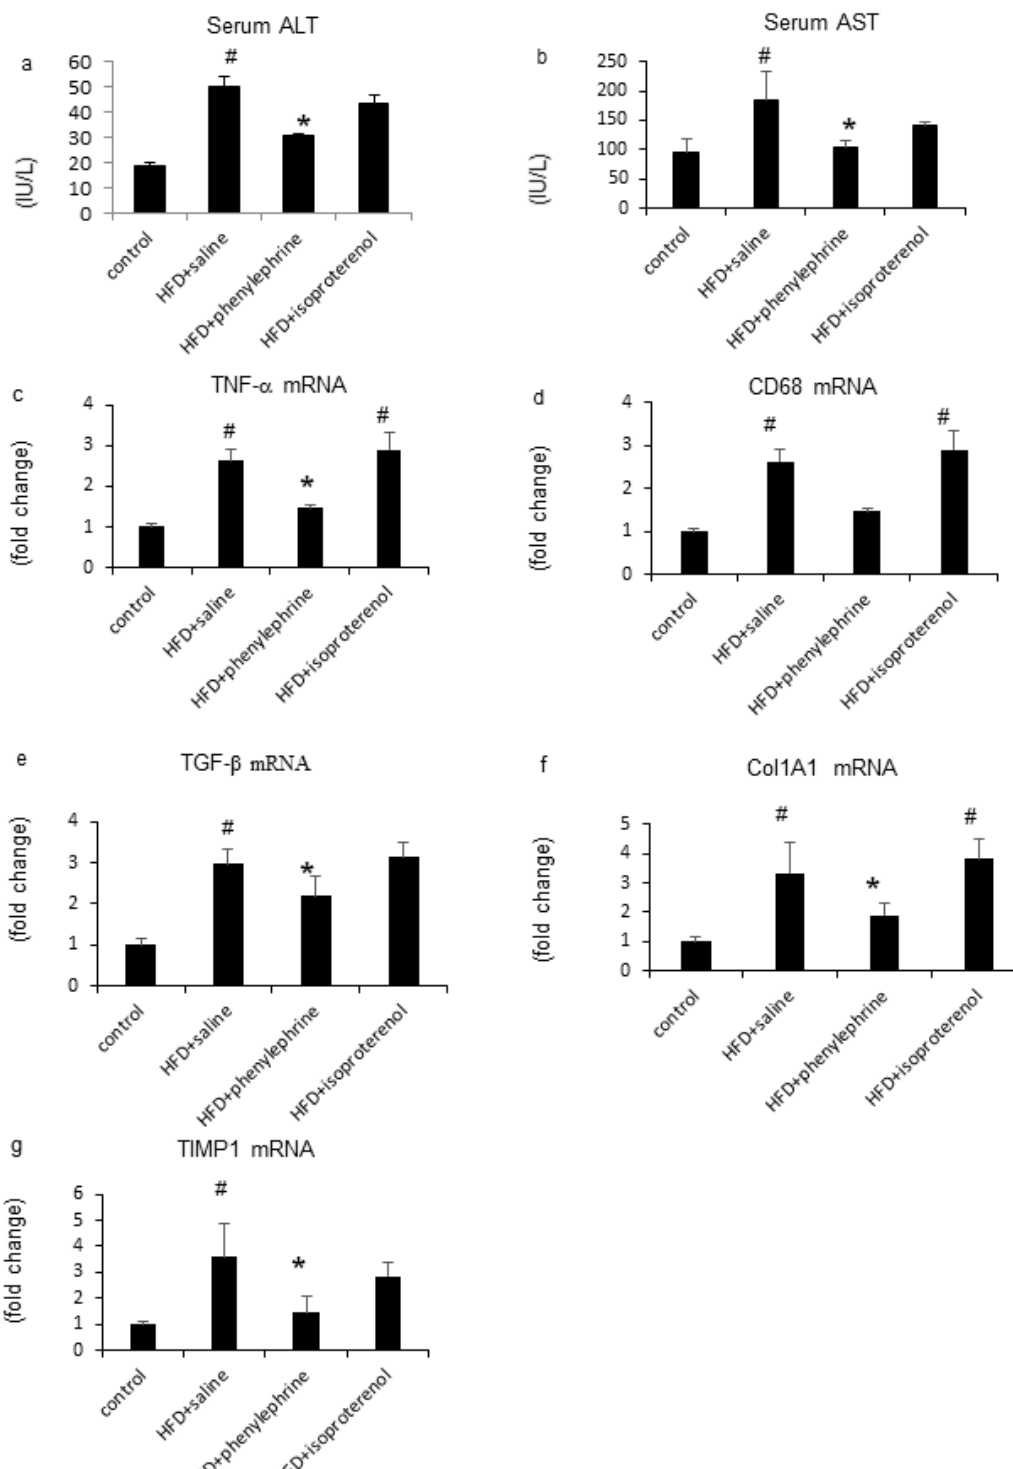
Figure 4. Evaluation of hepatic inflammation-related parameters. Serum alanine aminotransferase (ALT) levels ( a ) and aspartate aminotransferase (AST) levels ( b ). Relative mRNA expression levels of TNF- α ( c ), CD68 ( d ), TGF- β ( e ), Col1A1 ( f ), and TIMP1 ( g ) were evaluated in the liver. Statistical analysis was performed using ANOVA. Data are expressed as means ± SE. # p < 0.05 for HFD with saline or isoproterenol group compared with the control group. * p < 0.05 for HFD with phenylephrine group compared to HFD with the saline group.